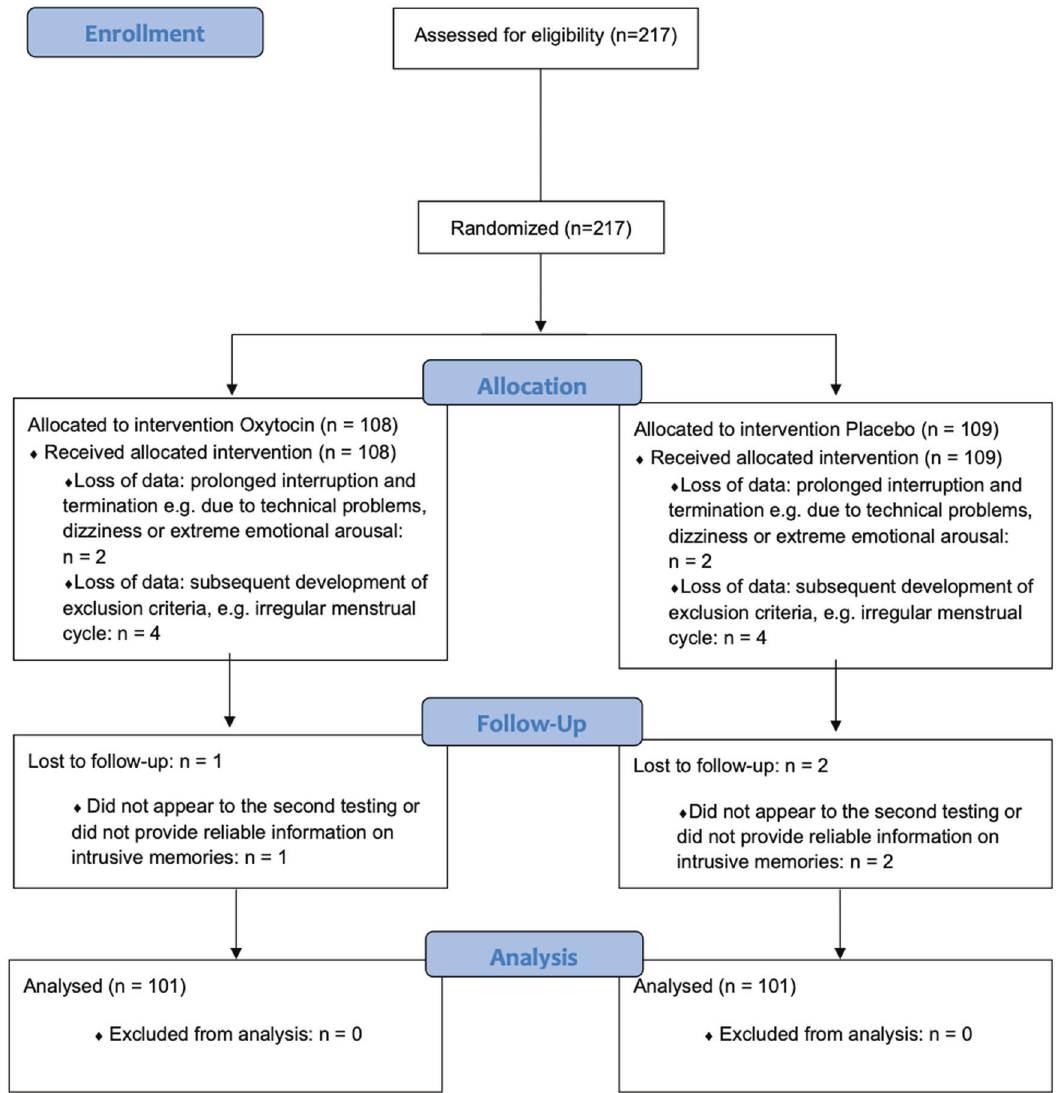
Fig. 1 Flow diagram. Flow chart showing the inclusion and exclusion of participants during the course of the Supplementary Table 1. To account for remaining population strati fi cation within the European sample the fi rst four PCs were added as covariates in the fi nal statistical model.